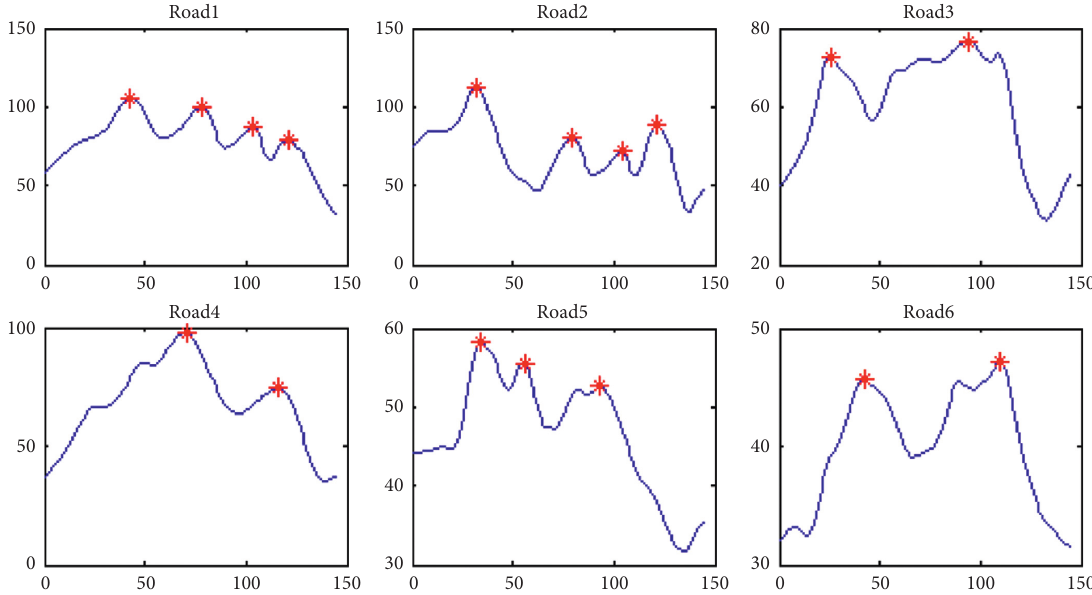
Figure 19: The data smoothed with the wavelet db6 and the peaks picked.